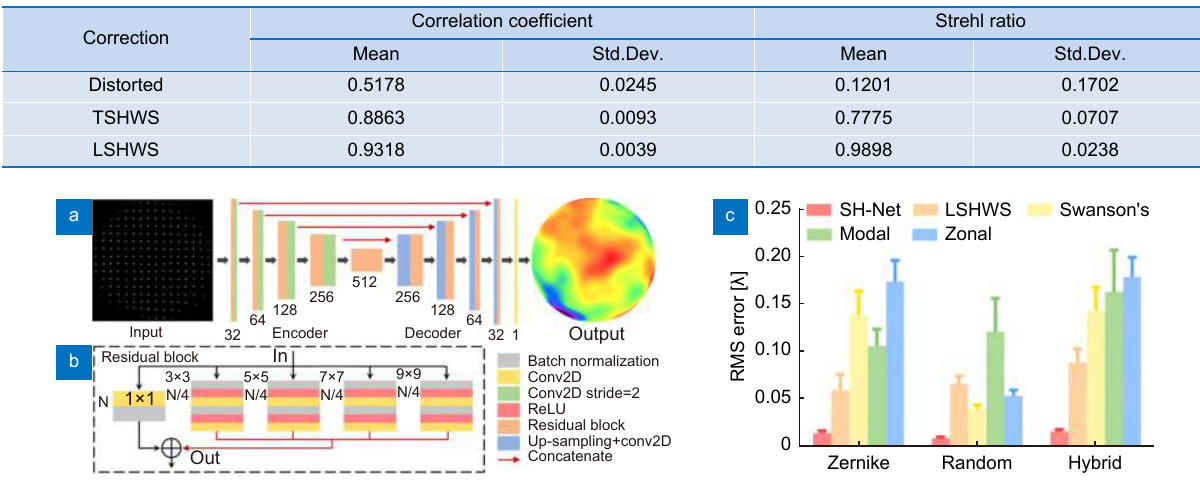
Fig. 8 | ( a ) Architecture of SH-Net. The input is a SHWFS image of size 256×256, and the output is a phase map with the same size as the input. ( b ) the Residual block. ‘N’ and ‘N/4’ indicate the number of channels. ( c ) Statistical results of RMS wavefront error of five methods in wavefront detection. Figure reproduced from: (a–c) ref. 77 , Optical Society of